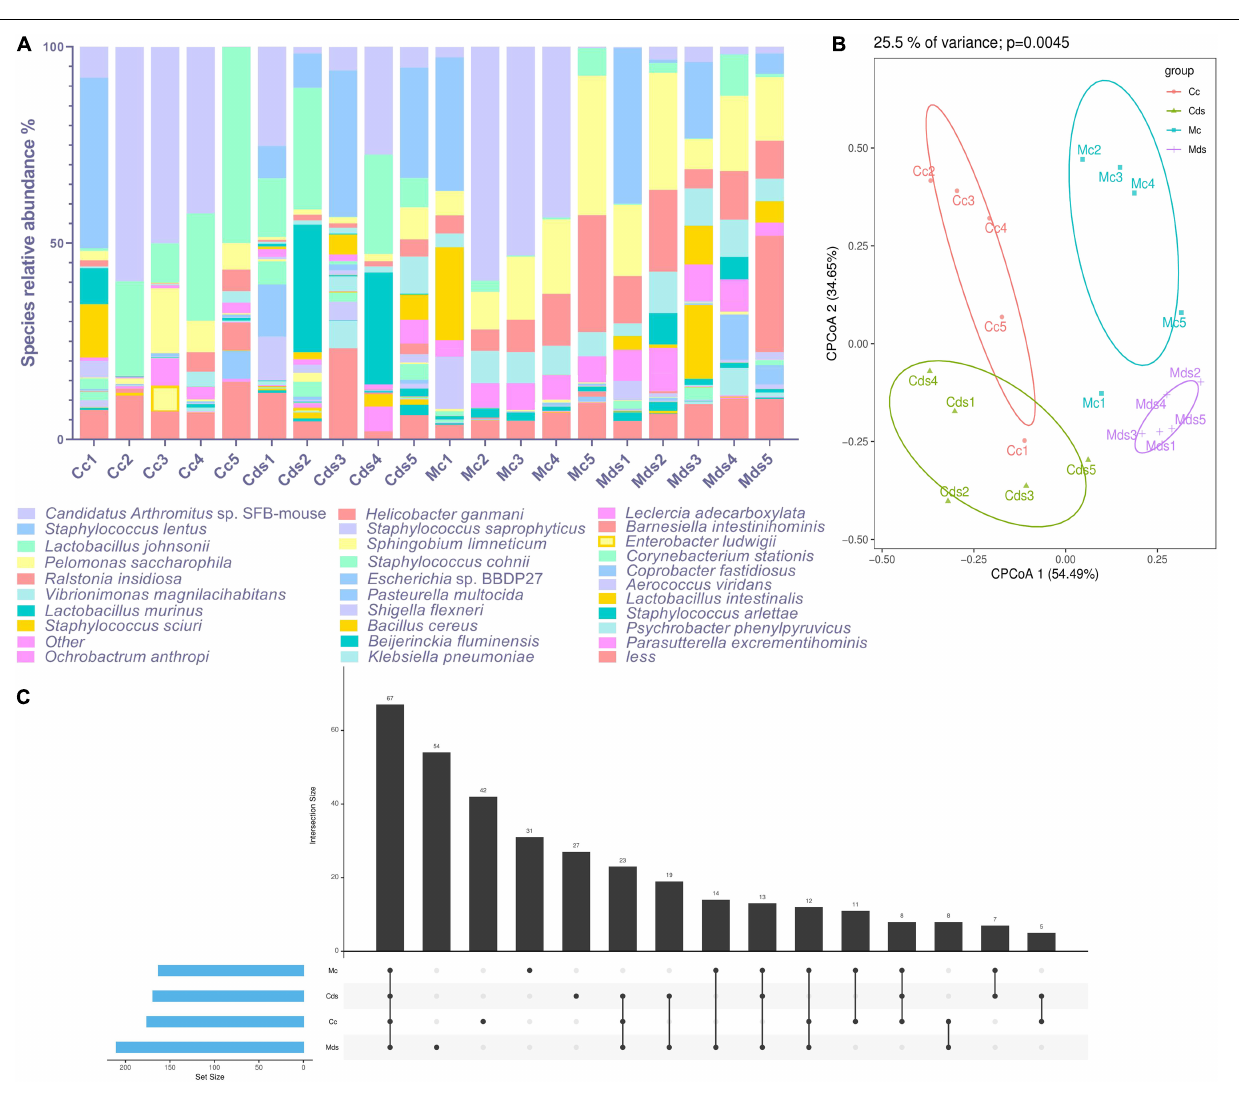
FIGURE 2 | Repeated stress-related diarrhea significantly perturbs the diversity and composition of intestinal microbiota at the species level. (A) The composition of dominant taxonomic species in each sample. (B) Cluster analysis of PCoA based on taxonomic bacterial species. (C) UpsetView of taxonomic bacterial species in groups. Cc, intestinal contents in control mice; Cds, intestinal contents in repeated stress-related diarrhea mice; Mc, intestinal mucosa in control mice; Mds, intestinal mucosa in repeated stress-related diarrhea